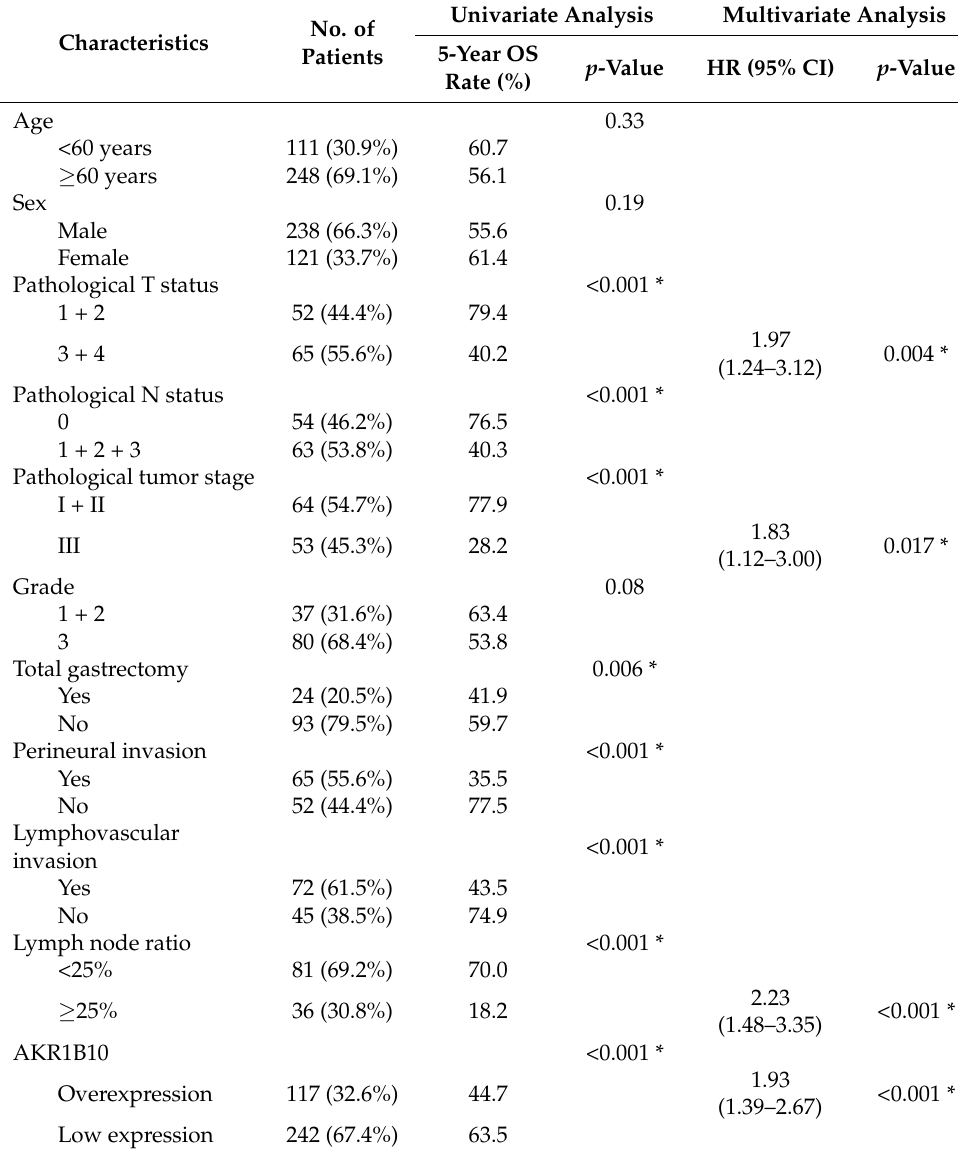
Table 4. Univariate and multivariate analyses of overall survival (OS) in 359 gastric adenocarcinoma patients receiving